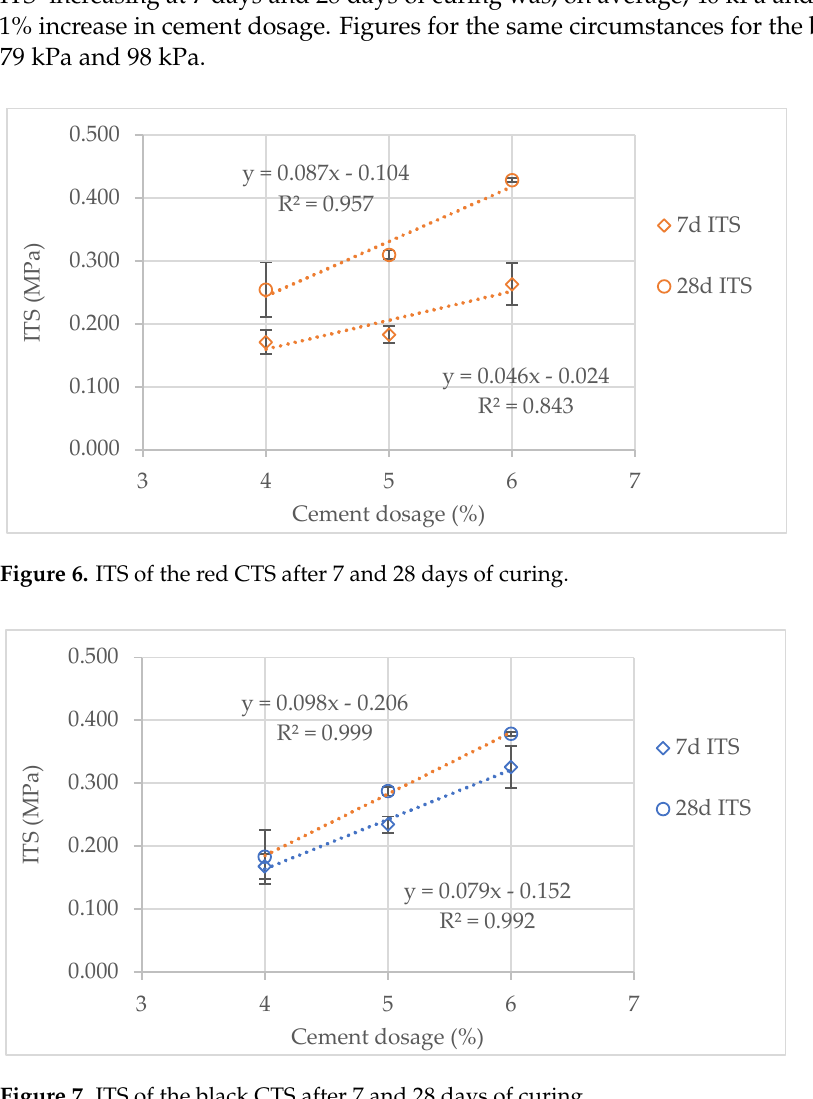
Figure 7. ITS of the black CTS after 7 and 28 days of curing.